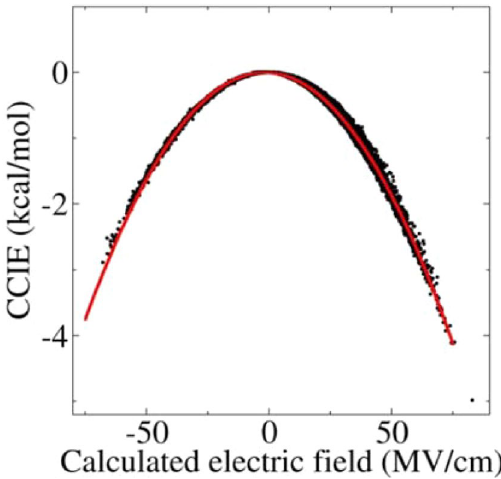
Figure 5. Distribution of the CCIEs between the QM (CO molecule) and the MM (the surroundings) as a function of the electric fields along the CO bond, which exhibits a quadratic function relationship. The influence on the CCIEs of the changes in the bond length of the CO was